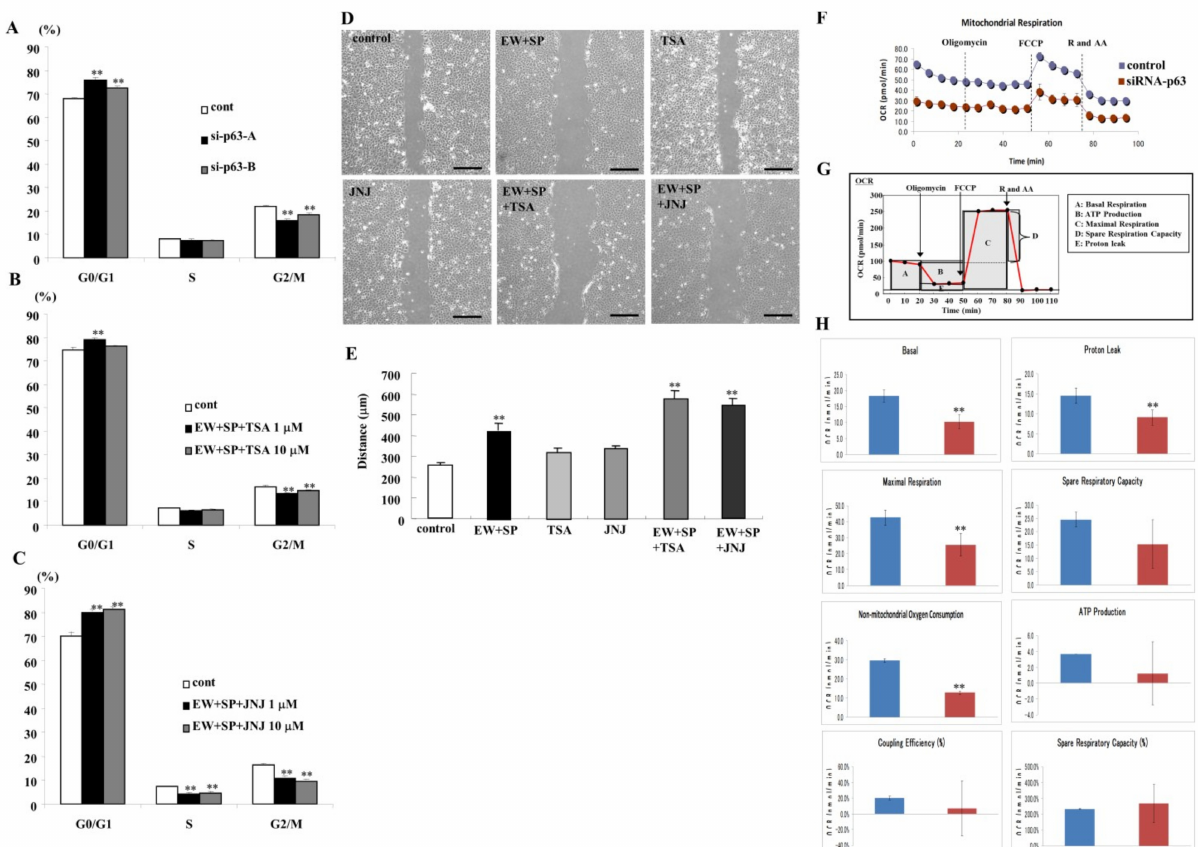
Figure 5. Cell cycle assay of A253 cells transfected with siRNA-p63 ( A ) and treated with or without TSA ( B ) and JNJ ( C ) at 1 and 10 µ M in the presence of EW-7197 and SP600125 at 10 µ M. ** p < 0.01. ( D ) Images of scratch wound assay of A253 cells treated with or without TSA and JNJ at 10 µ M with or without EW-7197 and SP600125 at 10 µ M. Scale bar: 200 µ M. ( E ) The result of ( D ) is shown as a bar graph. ( F ) Line graph and ( H ) bar graphs of OCR in A253 cells transfected with siRNA of p63. ( G ) Schema of OCR measured the key parameters of mitochondria function in line graph. Steady-state OCR was measured at six time points. Oligomycin was injected to inhibit ATP synthase, with the addition of FCCP to uncouple mitochondria and obtain the maximal oxygen consumption rate at the eighth time point. Finally, rotenone and antimycin A (R and AA) were injected to confirm that the respiration changes were due mainly to mitochondrial respiration. ** p <